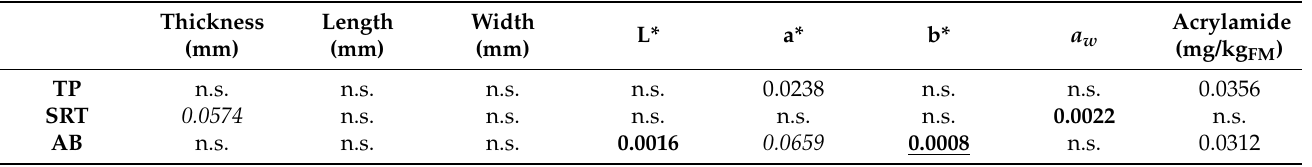
Table 4. Wilcoxon rank-sum (Mann–Whitney U